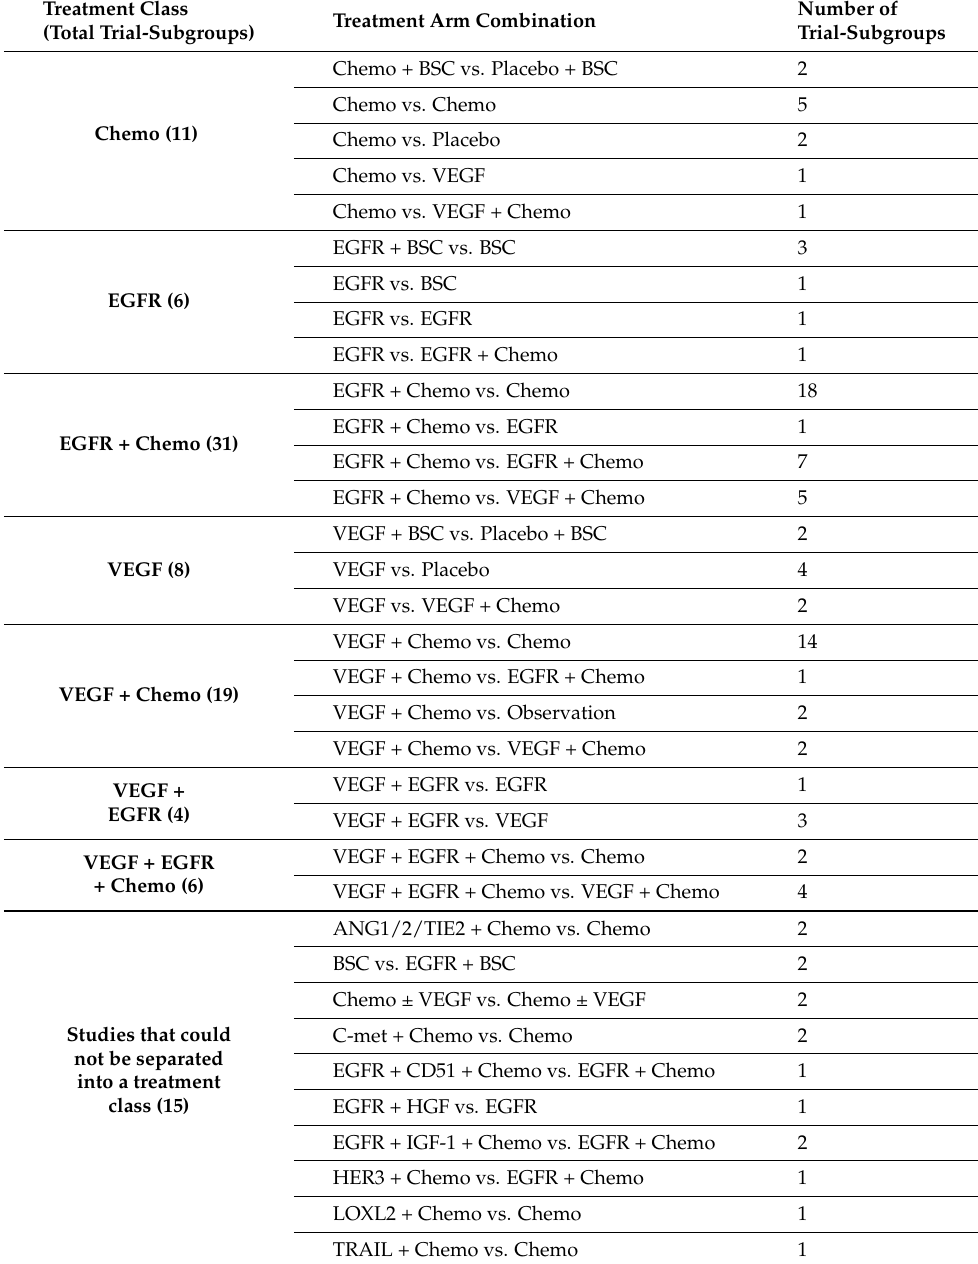
Table 1. Summary of treatment arm combinations of included trials within each treatment class. Each trial was assigned to a treatment class based on the mechanism of action of the experimental arm of the trial. Chemo = Chemotherapy, EGFR = Epidermal Growth Factor Receptor, VEGF = Vascular Endothelial Growth Factor, BSC = Best Supportive